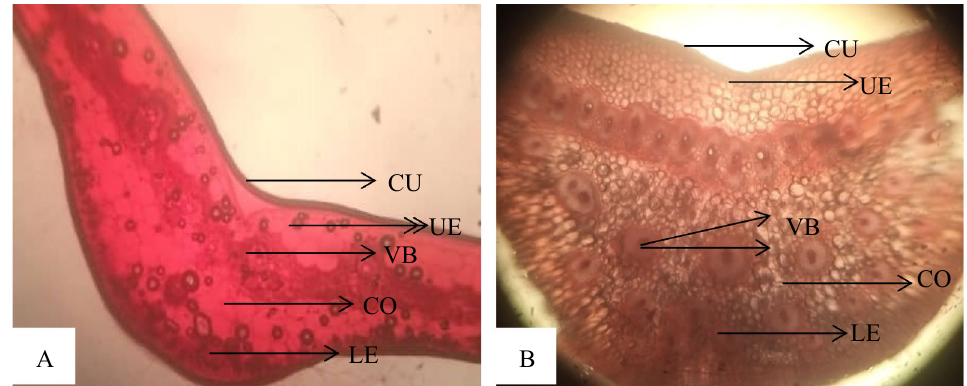
Fig. 4 Transverse sections of mid rib of leaves 100; A Costus afer B Palisota hirsute. CO: collenchyma; CU: Cuticle; LE PP: palisade parenchyma; UE: × upper epidermis, VB: vascular bundle. Briefly, scalpel was used to cut a tiny strip of the plants through the midrib region. The transverse sections obtained were cleared using 2% v/v sodium hypochlorite, washed severally in water, stained with Safranin O, dehydrated in 50%, 70% and 100% Ethanol, mounted in dilute, glycerol, viewed under microscope and, photomicrograph taken, with the, aid, of phone camera